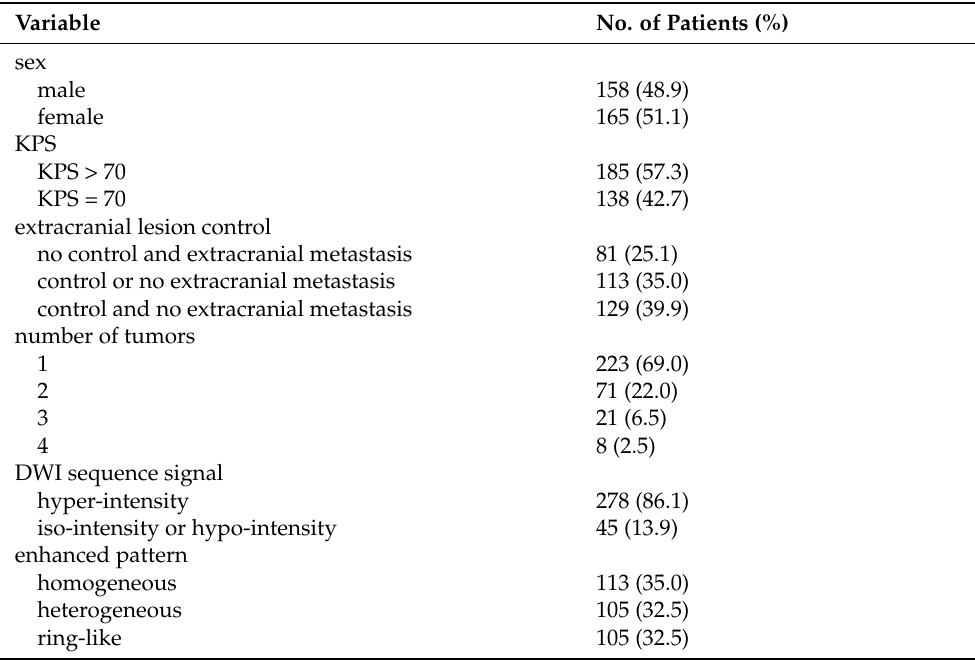
Table 1. Summary of patient